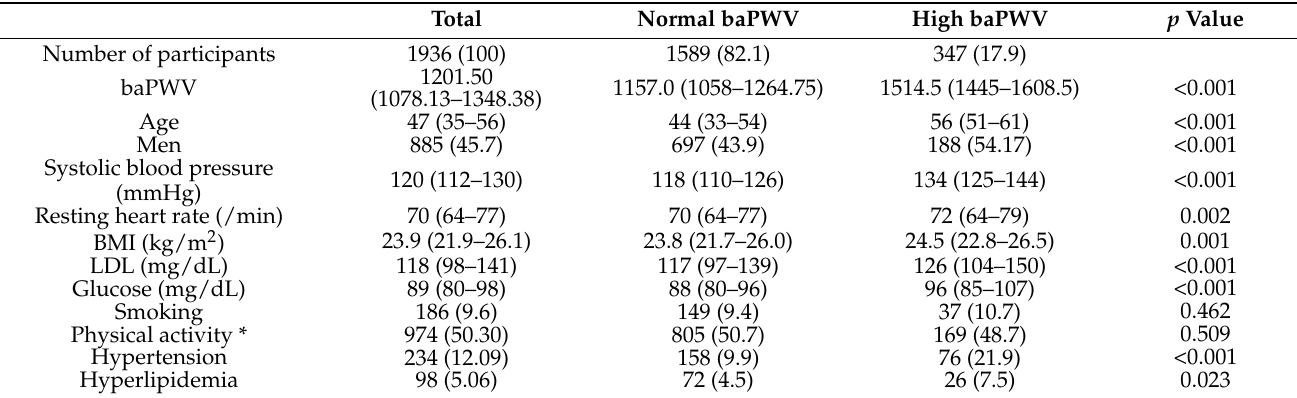
Table 1. Baseline characteristics of the study